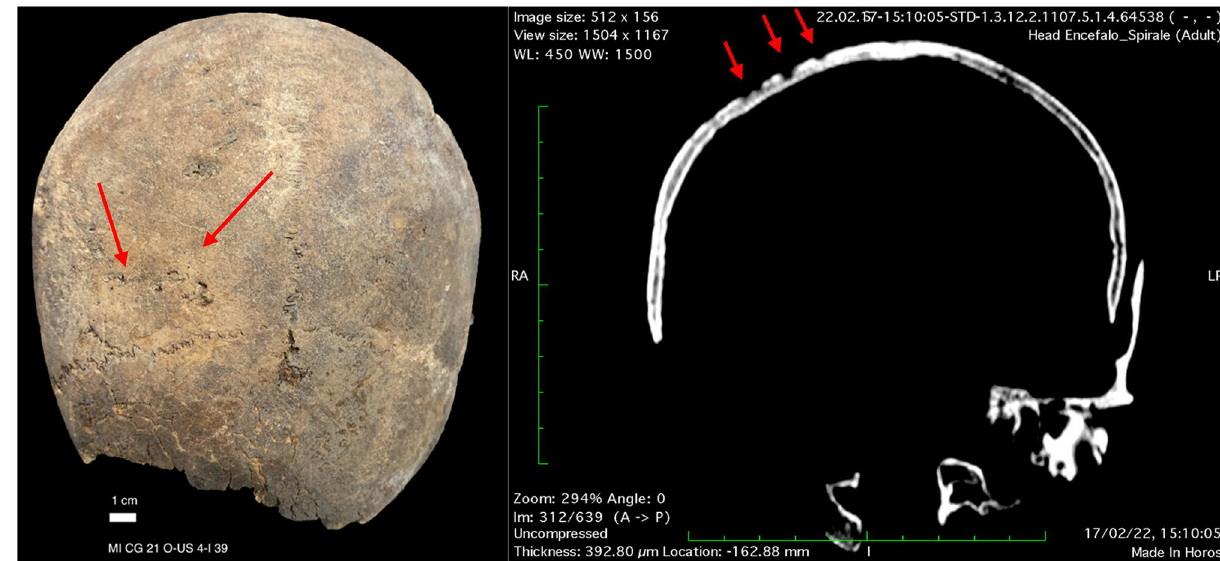
Figure 1. Signs of tertiary syphilis on cranium MI CG 21 O-US 4-I 39 (red arrow), both photographs and CT